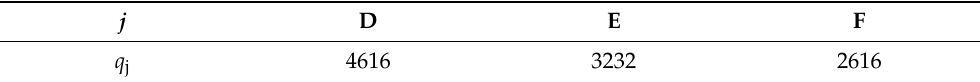
Table 1. Two-week production